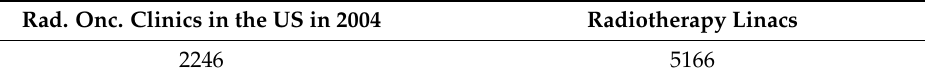
Table 3. Radiation oncology clinics and radiotherapy linacs were available in the United States in 2004.